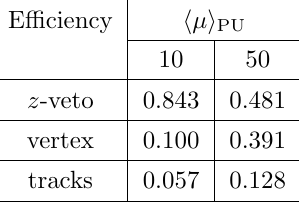
=M = 200 GeV/180 GeV l e (cid:31) 0 1